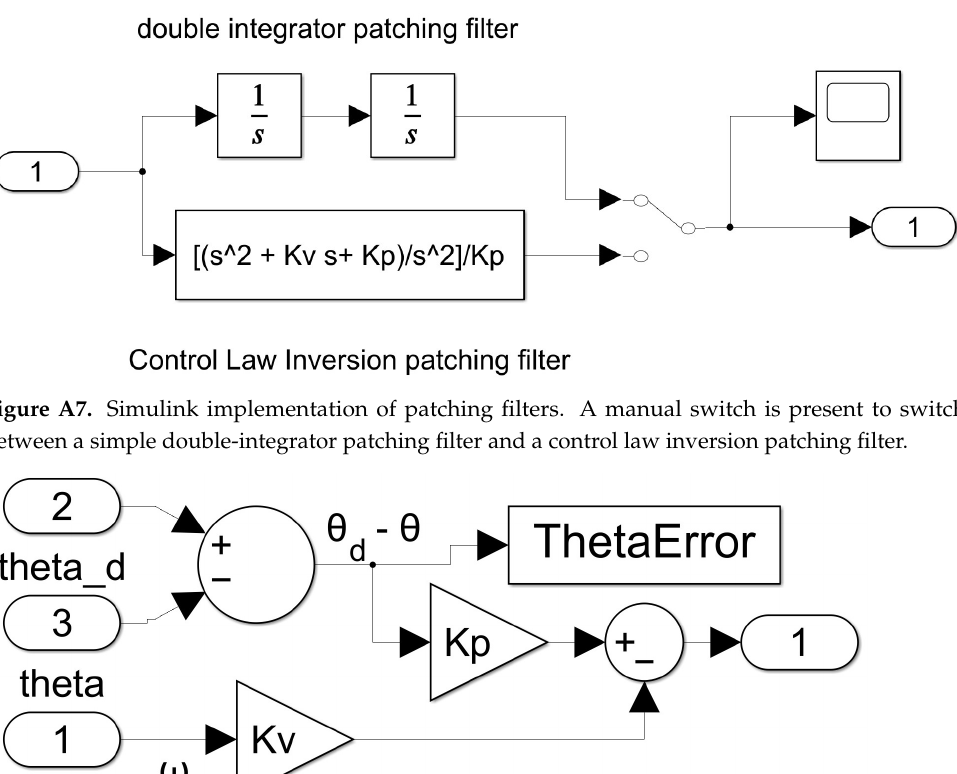
Figure A6. Determinant switching logic for RTOC. When the absolute value of det[ T ] < 0.001, the switch flips to open-loop optimal control.